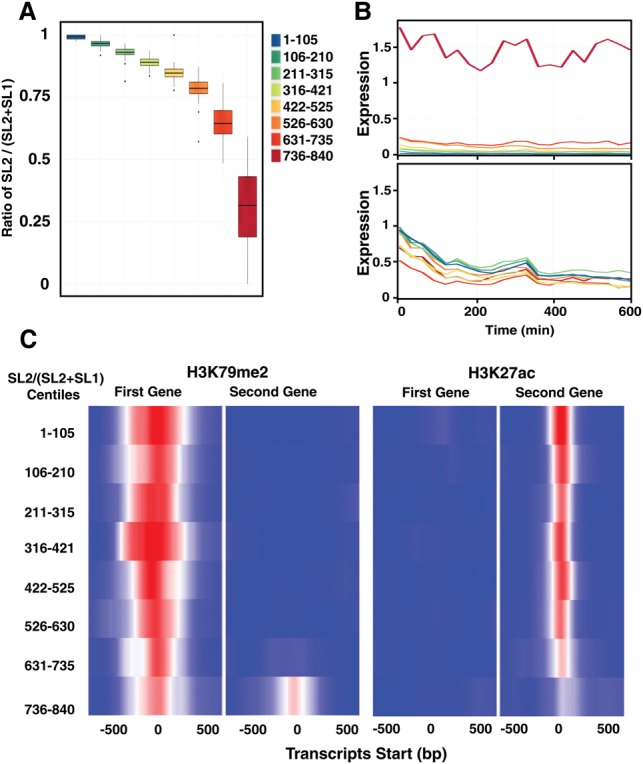
Operon gene regulation across development. (A) A box plot of the ratio of SL2 reads to all splice leader reads for all second genes in operons across the embryonic time series 0223. Well-expressed second genes in operons (dcpm ≥0.1) were divided into eight equally sized bins (105 genes) based on the overall SL2 fraction. Outliers may indicate stage-specific usage of the two promoters. (B) The same eight bins showing average SL1 (top) and SL2 (bottom) expression in dcpm across development for the second genes. (C) Average H3K27ac signal across the transcript start site of the first (left) and second (right) gene in operons, divided into the same eight bins as in A. Marks of open chromatin may serve to maintain open chromatin for polymerase read-through during transcription of the operon. Average H3K79me2 signal across the transcription start site of the first (left) and second (right) gene in operons, divided into the same eight bins as in A. Promoter areas of these second genes are sites of active regulation.